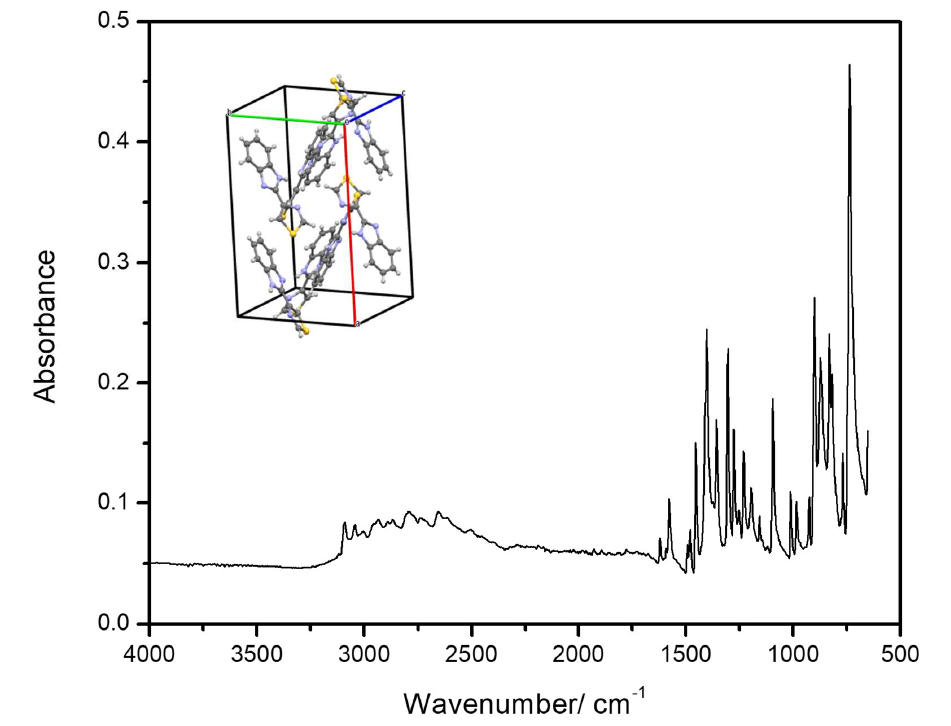
Figure15. Roomtemperatureinfraredspectrumofcrystallinethiabendazole(attenuatedtotalreflectance Figure 15. Room temperature infrared spectrum of crystalline thiabendazole (attenuated total (ATR)). Inset: unit cell of the crystal of the compound reflectance (ATR)). Inset: unit cell of the crystal of the compound [11].